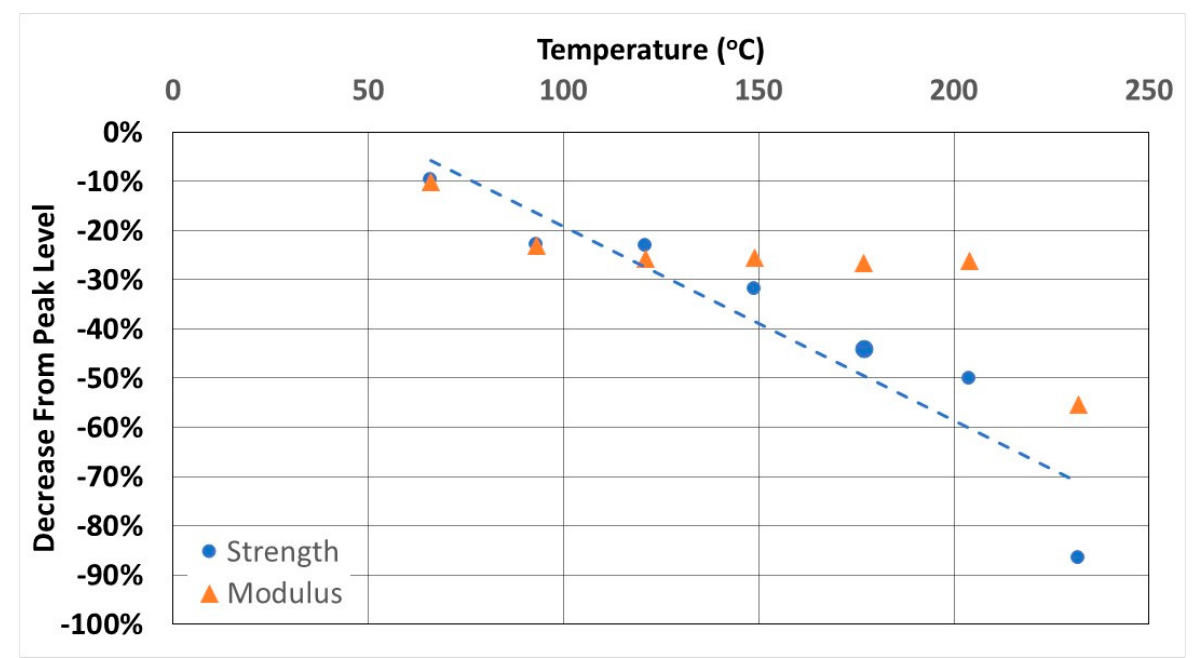
Figure 5. Post peak decrease in Off-axis Shear Strength and Modulus as a function of temperature after 72 h exposure.